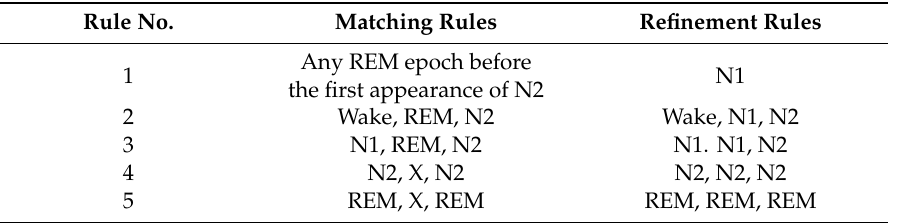
Table 6. Refinement rules [22] (X represents any